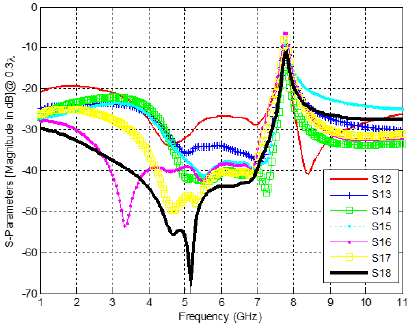
FIGURE 13. Parametric study of the broadband mutual coupling for different values of inter-element distance (0.3 λ ) (8 antennas array)